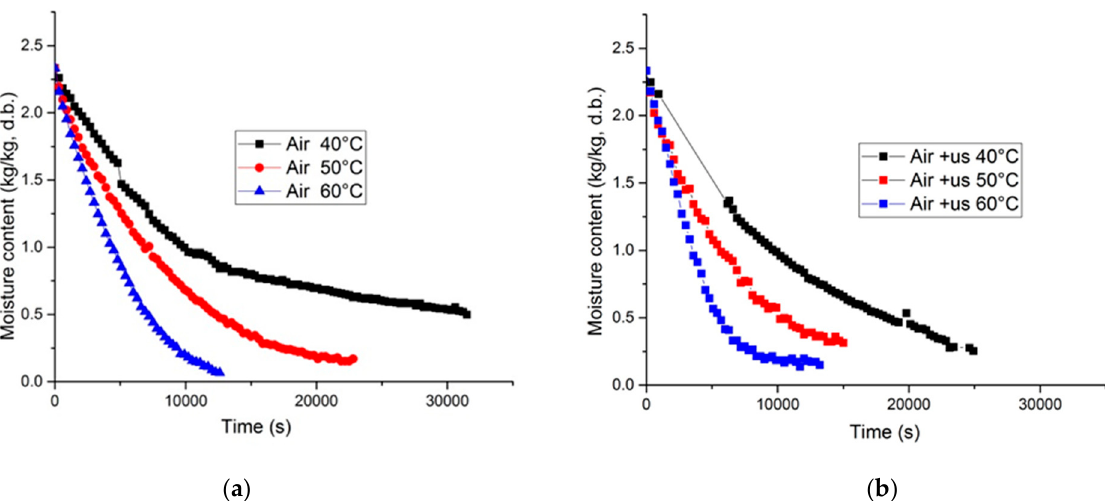
Figure 3. Experimental drying kinetics of the henna leaves determined at different temperatures (40, 50 and 60 °C): ( a ) without ultrasound application (Air); and ( b ) with ultrasound application (Air + us; 20.5 kW/m 3 ; 21.7 kHz).